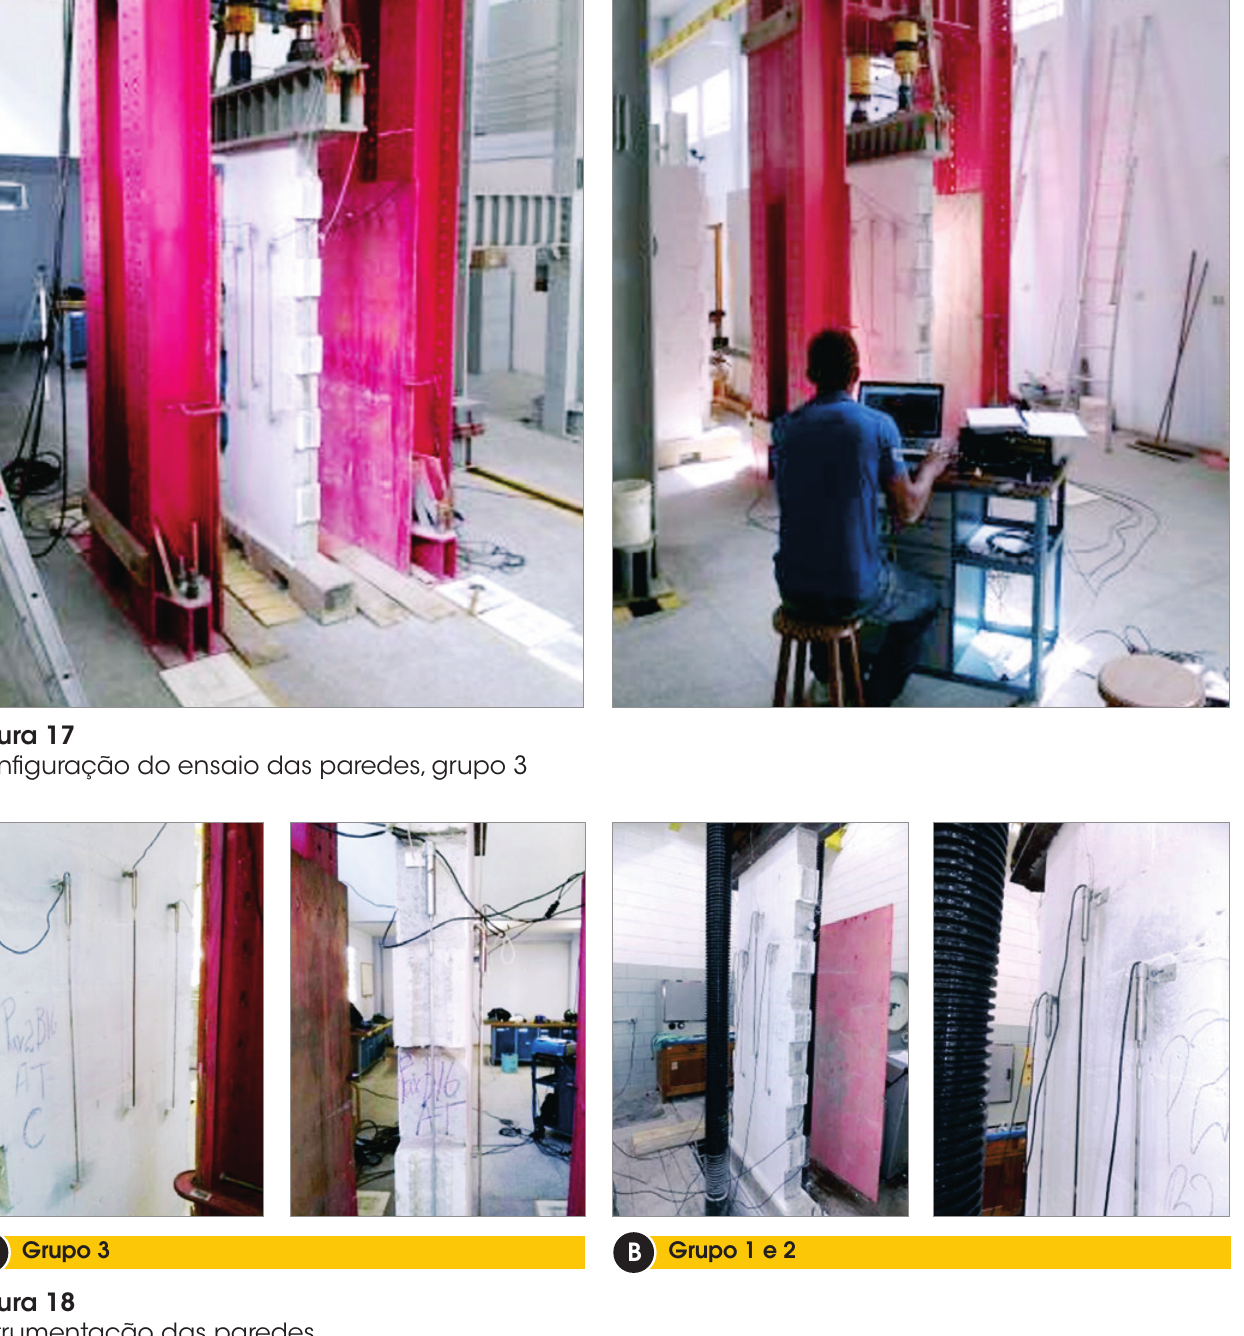
Instrumentação das